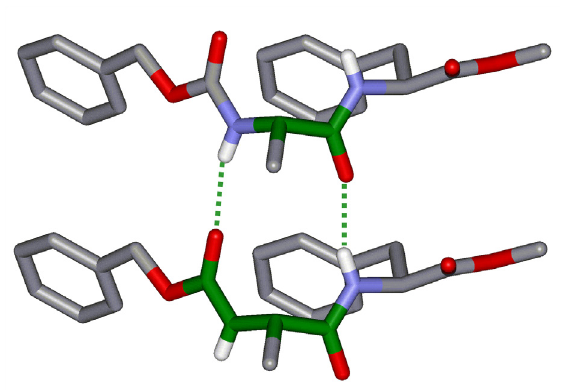
Figure 2. Representation of two H-bonded molecules of Z-AF-OMe forming a R 2 ring, highlighted in green. Non-polar H-bonds are omitted for clarity.